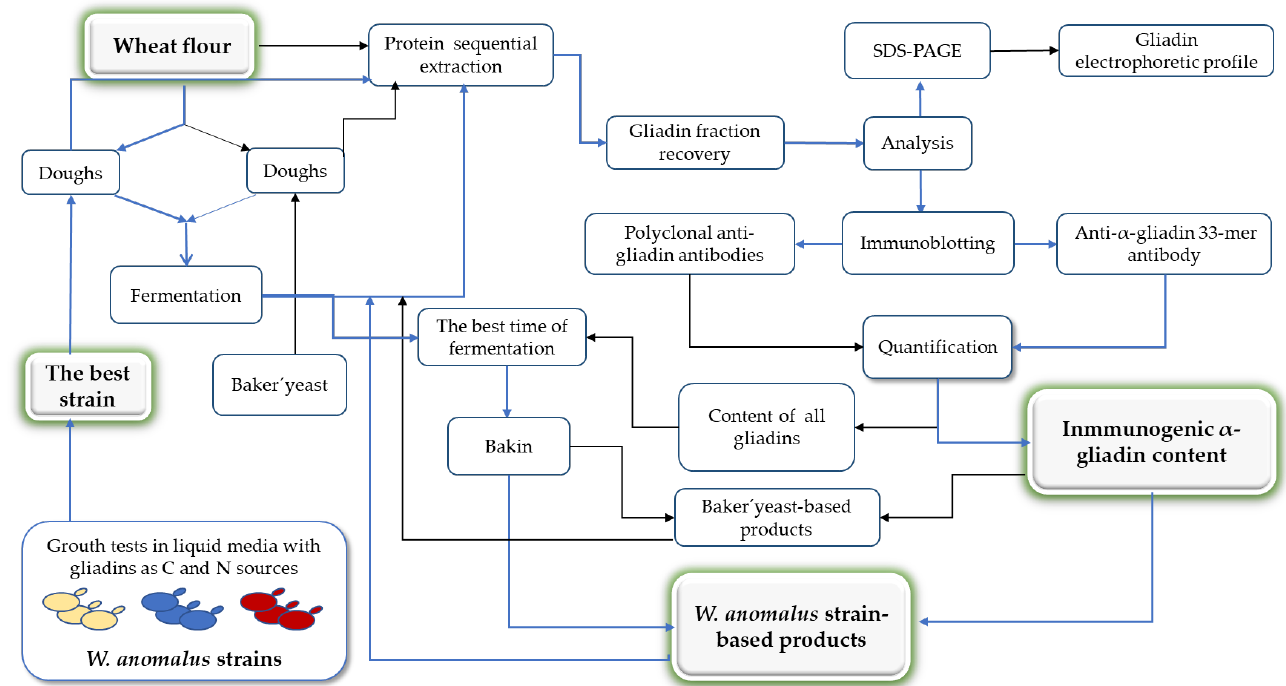
Figure 1. Workflow for exploring the ability of the yeast W. anomalus to hydrolyze immunogenic wheat gliadin proteins.